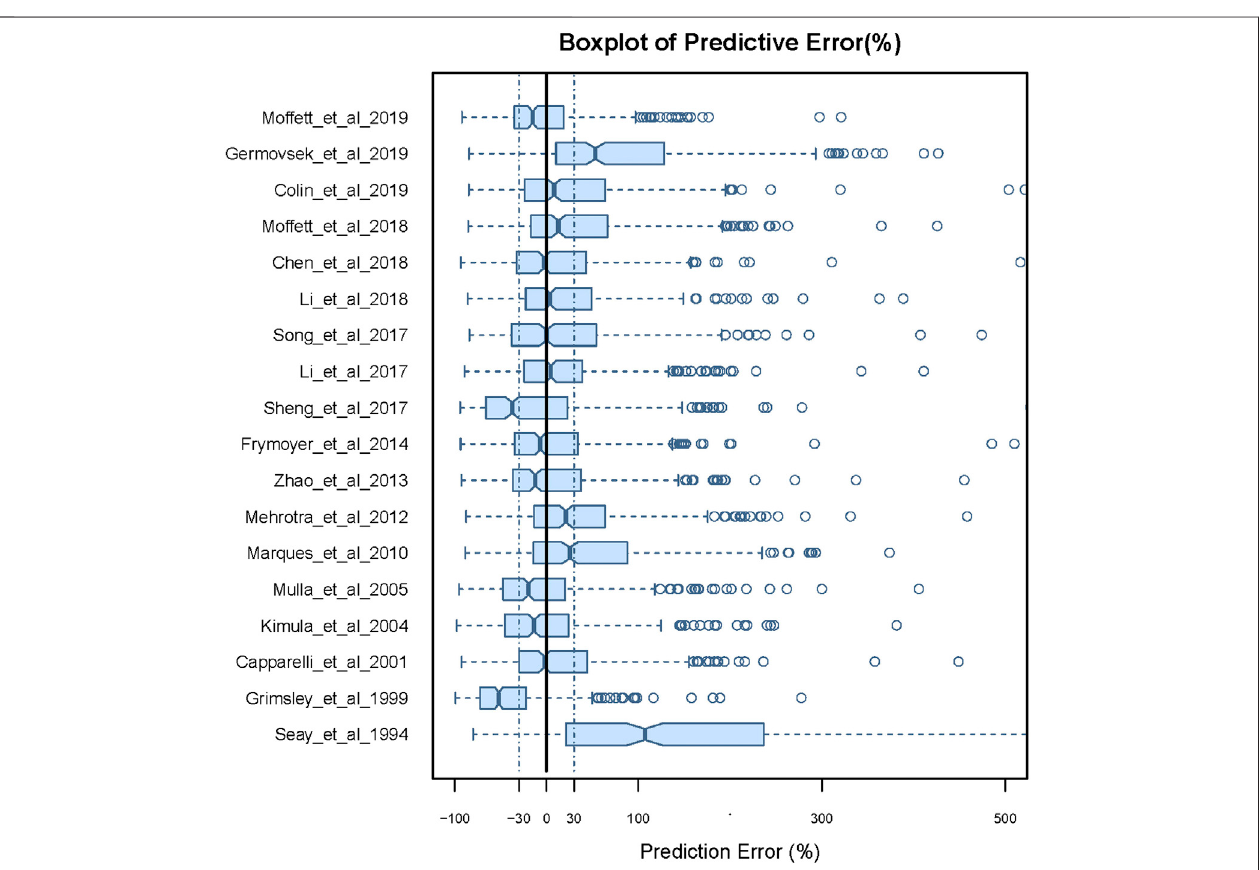
FIGURE 1 | Box plots of the prediction error (PE%) for published population pharmacokinetic models in external data. Black solid lines and blue dotted lines are reference lines indicating PE% of 0% and ± 30%, respectively.